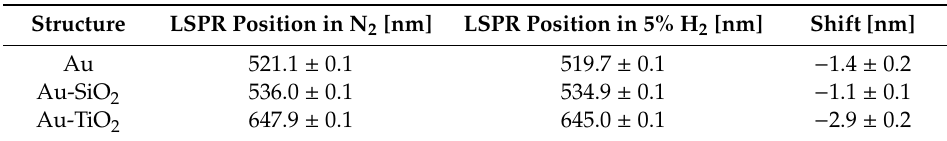
Figure 6. Gas sensing measurements on Au monolayer samples exposed to 5% H 2 at 300 °C. ( a ) Au monolayer coated with TiO 2 ; ( b ) dynamic sensing at 610 nm for a repeated N 2 -H 2 -N 2 cycle for the Au monolayer coated with TiO 2 ; ( c ) bare Au monolayer, ( d ) Au monolayer coated with SiO 2 . The insets show the Optical Absorbance Change (OAC) defined as the difference between the absorbance in H 2 and in N 2 (OAC = Abs H2 − Abs N2 ). Table 2. Au monolayer sensor: observed Au localized surface plasmon resonance (LSPR) shift in 5% H 2 atmosphere.